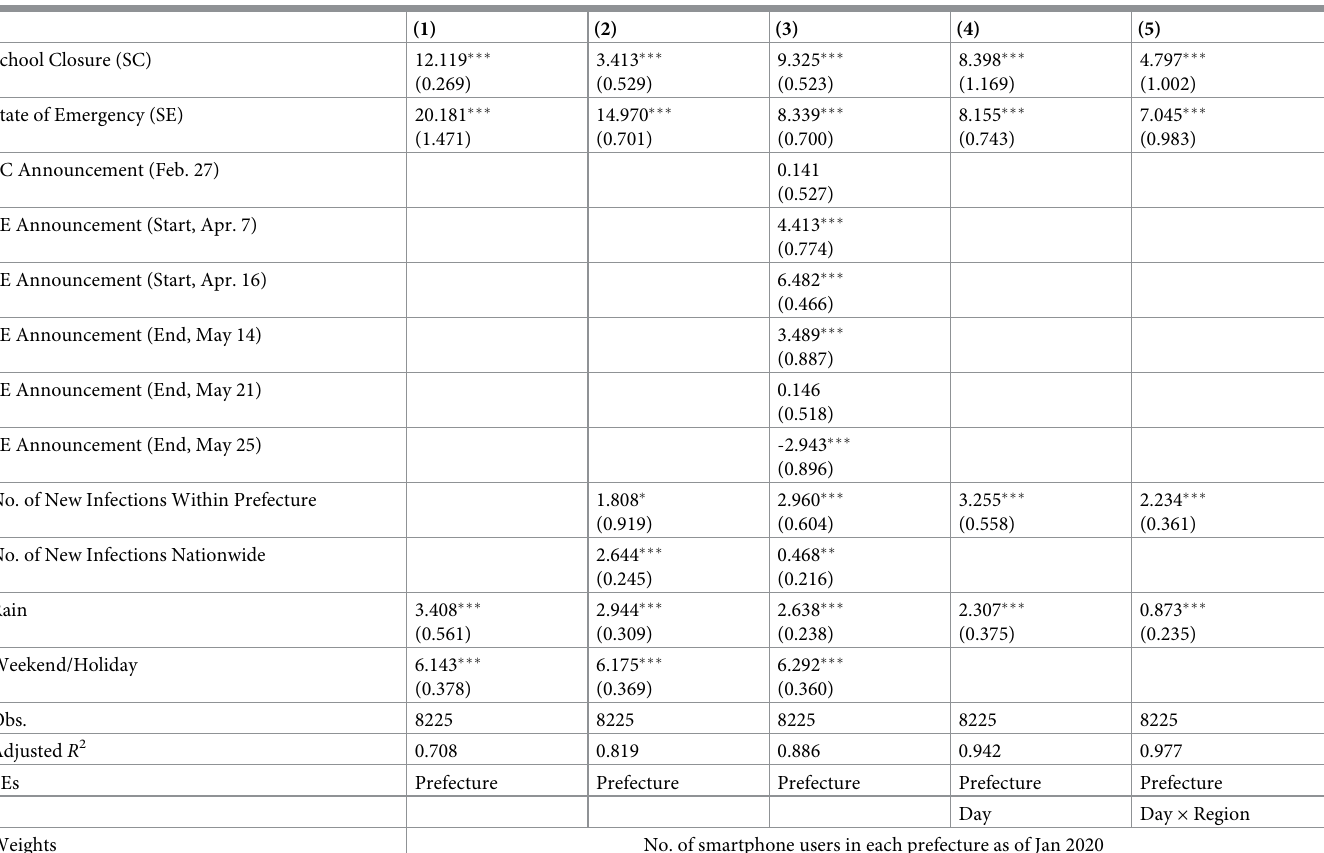
Table 1. Regression